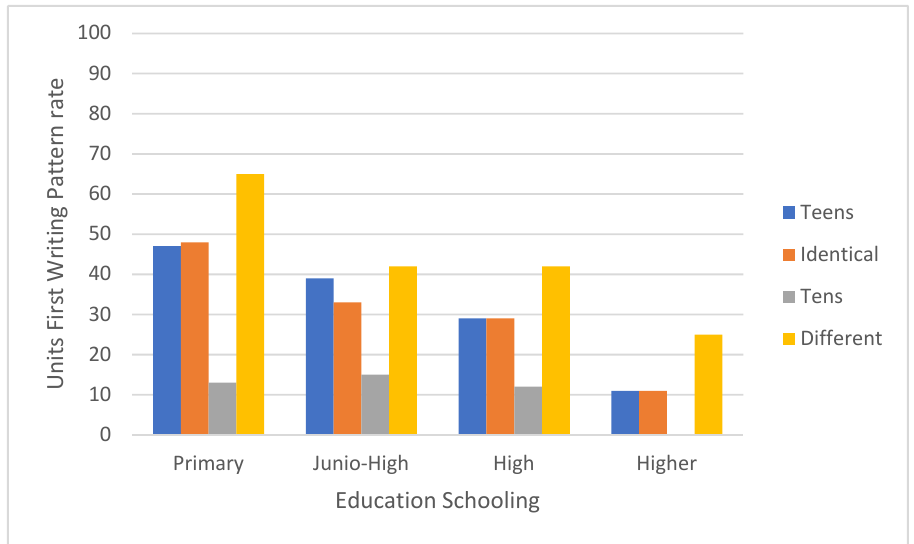
Figure 3. The units first (right to left) writing pattern rates as a function of two-digit numbers category (teens, identical, tens and different) and educational level (primary, junior-high, high, higher).